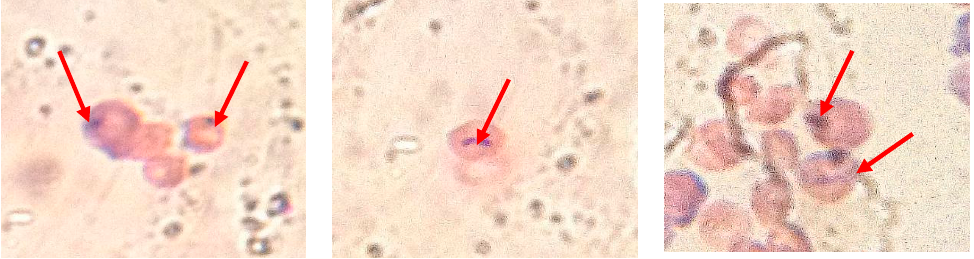
Figure 6. Bone marrow micronucleus pictures.